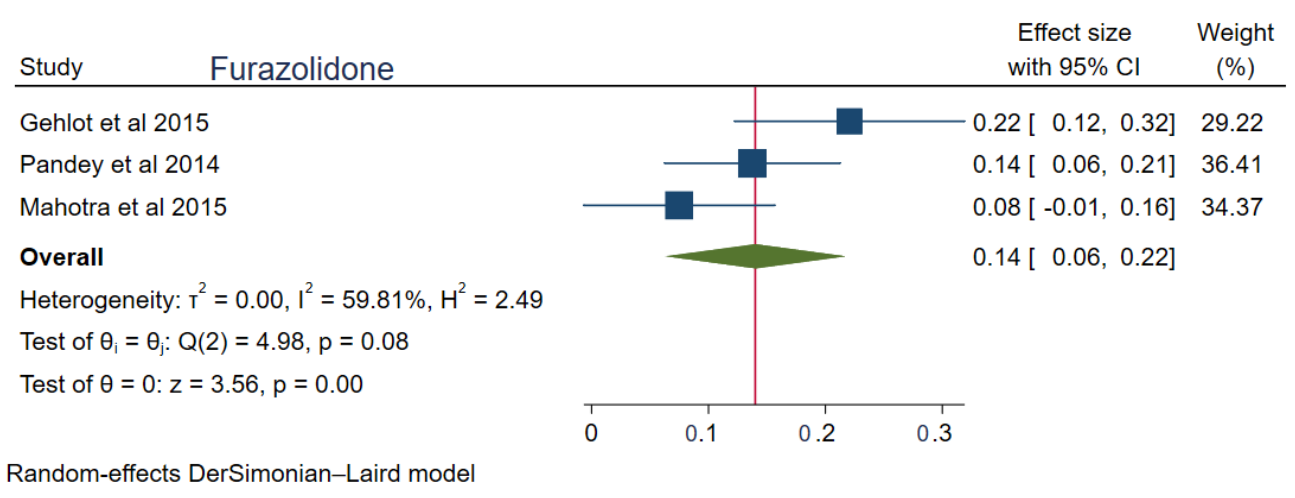
Figure 8. Forest Plot Showing Furazolidone Resistance. (Reference studies: [21, 25, 27])